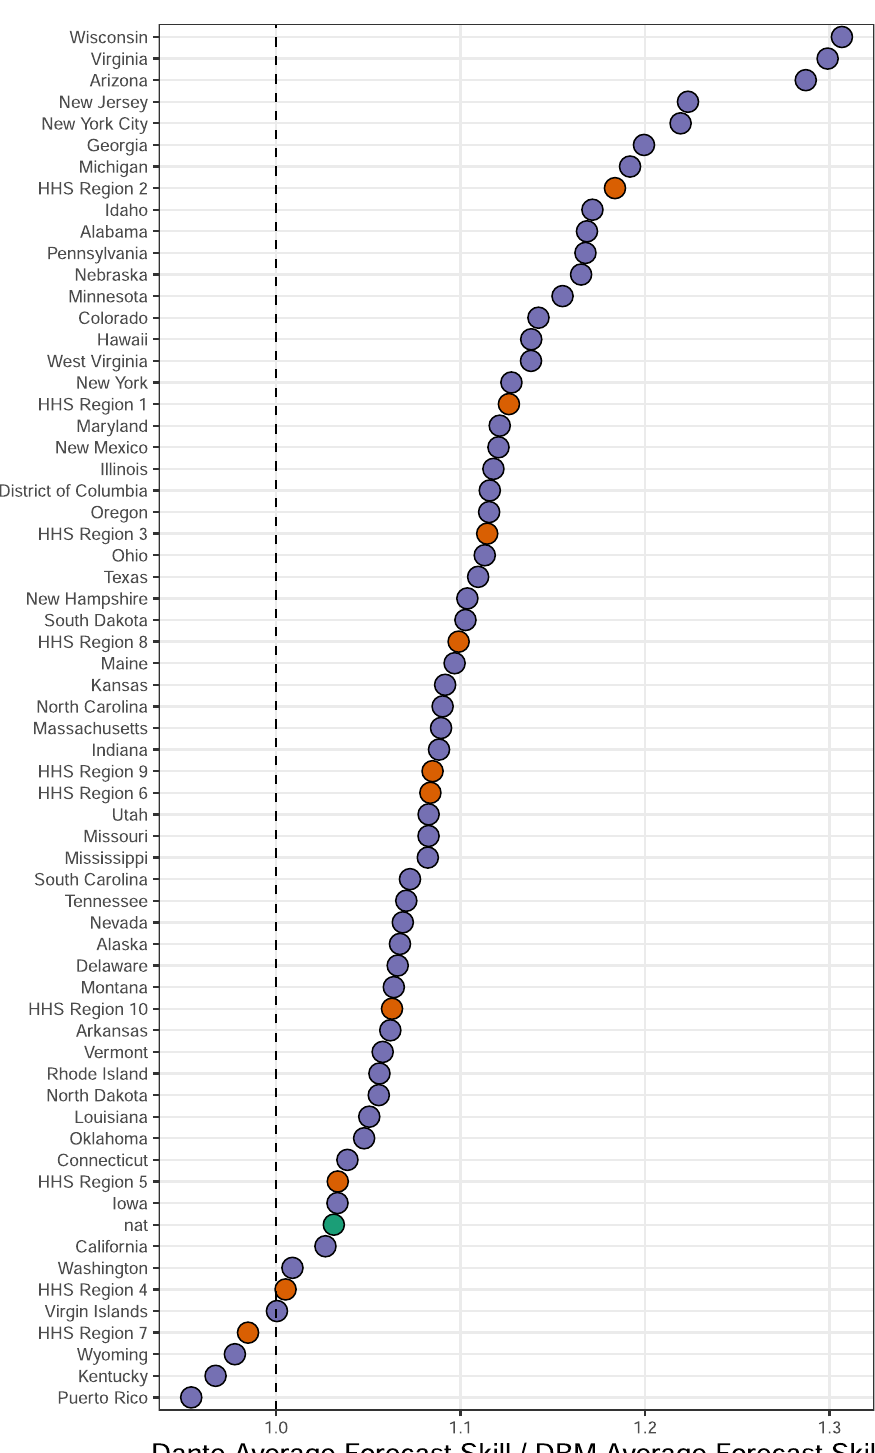
Fig. 4 Dante ’ s forecast skill relative to DBM ’ s by geographic region. Ratio of forecast skill of Dante to that of DBM, for all states, regions, and nationally. Dante had higher forecast skill for all geographic regions except for HHS Region 7, Kentucky, Wyoming, and Puerto